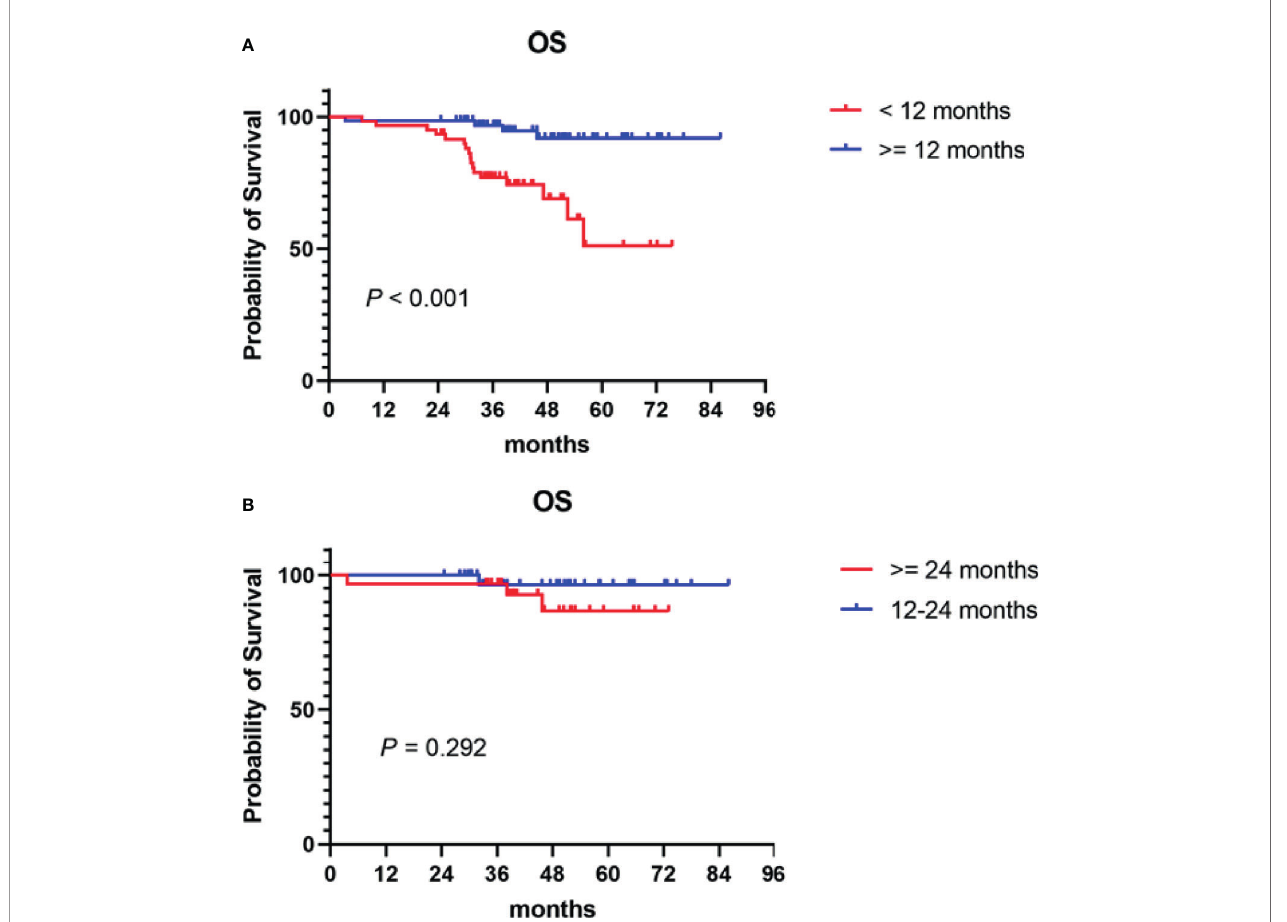
FIGURE 3 | Overall survival (OS) in NDMM patients who received PIs maintenance therapy of different treatment durations. Kaplan – Meier curves are shown for (A) patients who received ≥ 12 months of bortezomib-based maintenance therapy vs those who were given maintenance therapy for < 12 months; (B) patients